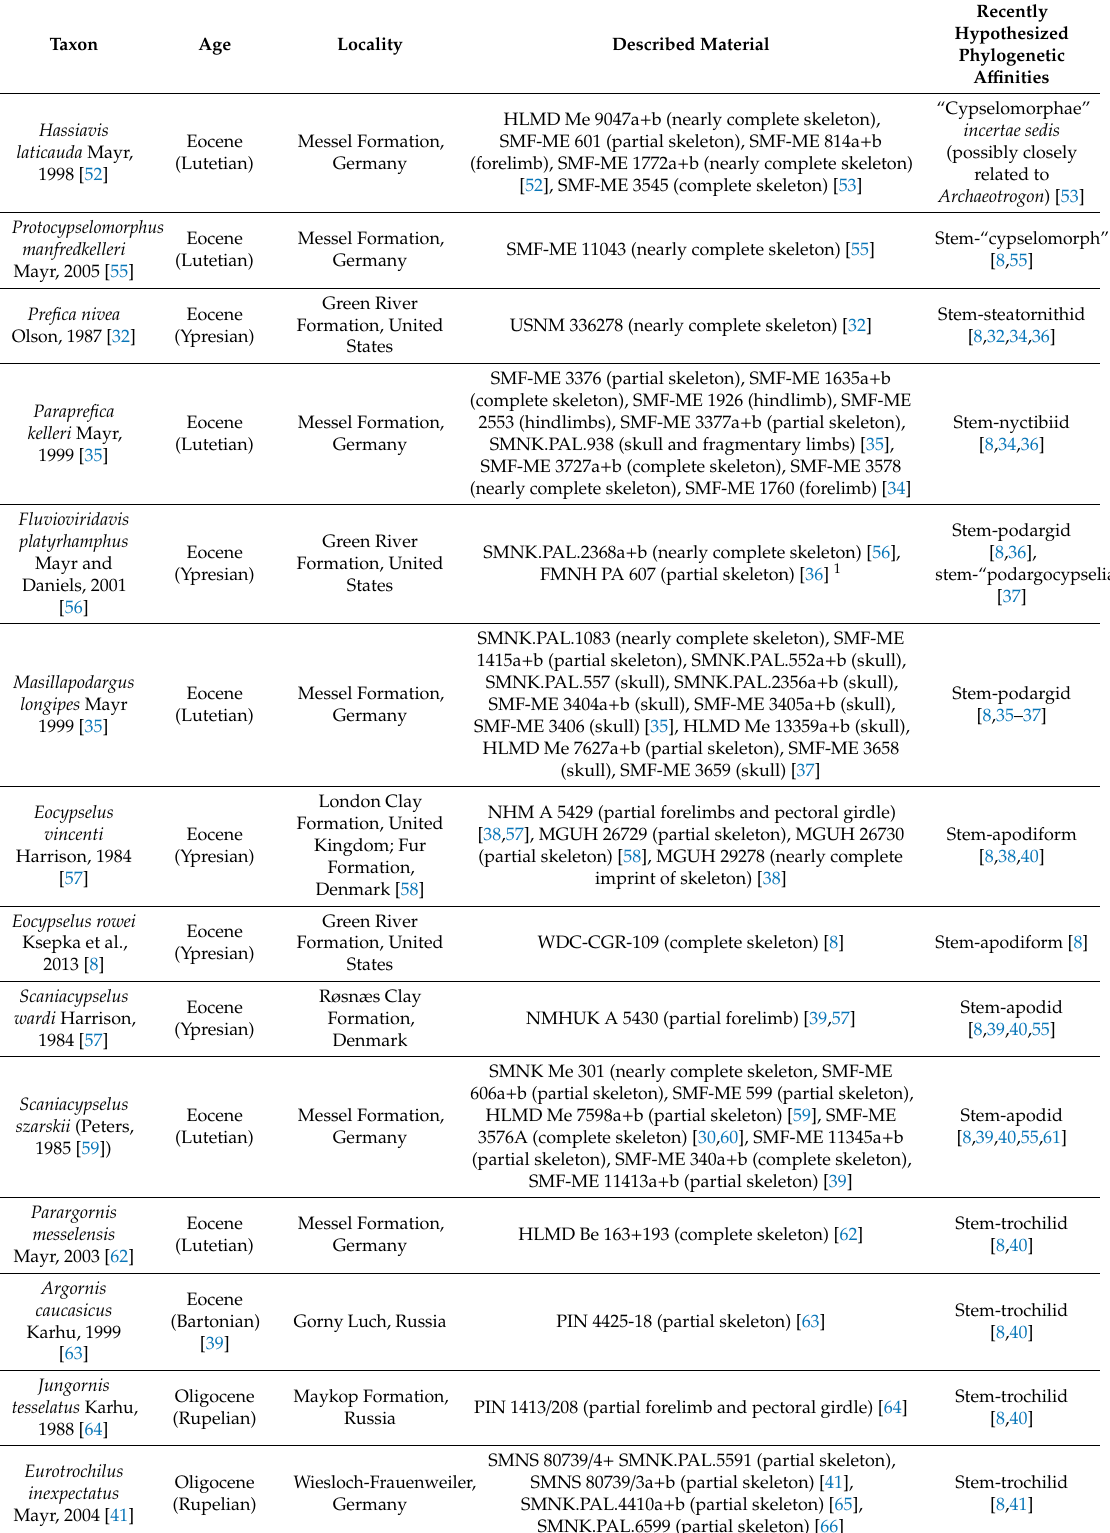
Table 1. Summary of current knowledge on fossil strisoreans included in this study. Unless otherwise stated, age and locality information are based on Mayr [30], Ksepka and Clarke [54], and the original descriptions of the taxa